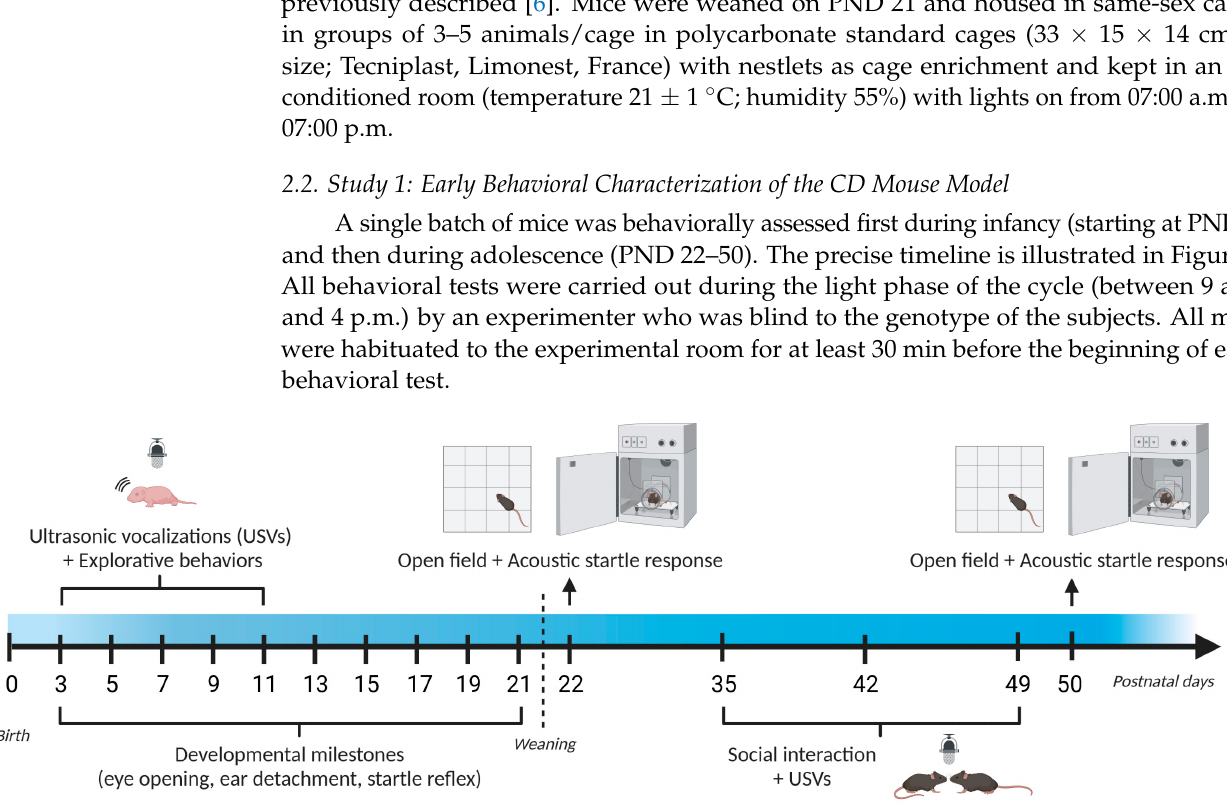
Figure 1. Timeline of behavioral assessment (Study 1). A single batch of CD mice (12 males and 11 females) and their WT littermates (17 males and 16 females) were assessed at infancy (during the